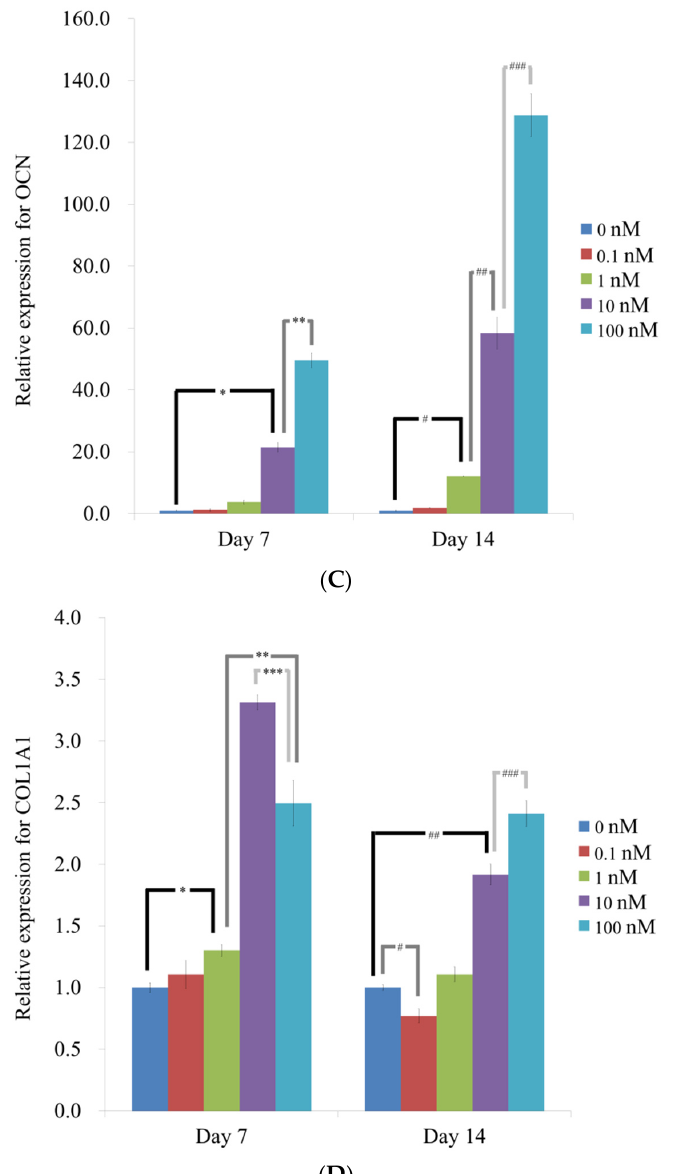
Figure 5. ( A ) Quantification of expression of RUNX2 mRNA by real-time polymerase chain reaction on days 7 and 14. * p < 0.05 versus the 0 nM on day 7. ** p < 0.05 versus the 1 and 10 nM groups on day 7. # p < 0.05 versus the 0 nM group on day 14. ## p < 0.05 versus the 0 nM group on day 14. ### p < 0.05 versus the 10 nM group on day 14. ( B ) Quantification of expression of BSP mRNA by real-time polymerase chain reaction on days 7 and 14. * p < 0.05 versus the 0 nM on day 7. ** p < 0.05 versus the 10 nM group on day 7. # p < 0.05 versus the 0 nM group on day 14. ## p < 0.05 versus the 0 nM group on day 14. ### p < 0.05 versus the 0.1 nM group on Day 14. #### p < 0.05 versus the 10 nM group on day 14. ( C ) Quantification of expression of OCN mRNA by real-time polymerase chain reaction on days 7 and 14. * p < 0.05 versus the 0 nM on day 7. ** p < 0.05 versus the 10 nM group on day 7. # p < 0.05 versus the 0 nM group on day 14. ## p < 0.05 versus the 1 nM group on day 14. ### p < 0.05 versus the 10 nM group on day 14. ( D ) Quantification of expression of COL1A1 mRNA by real-time polymerase chain reaction on days 7 and 14. * p < 0.05 versus the 0 nM on day 7. ** p < 0.05 versus the 1 nM group on day 7. *** p < 0.05 versus the 10 nM group on day 7. # p < 0.05 versus the 0 nM group on day 14. ## p < 0.05 versus the 0 nM group on day 14. ### p < 0.05 versus the 10 nM group on day 14.